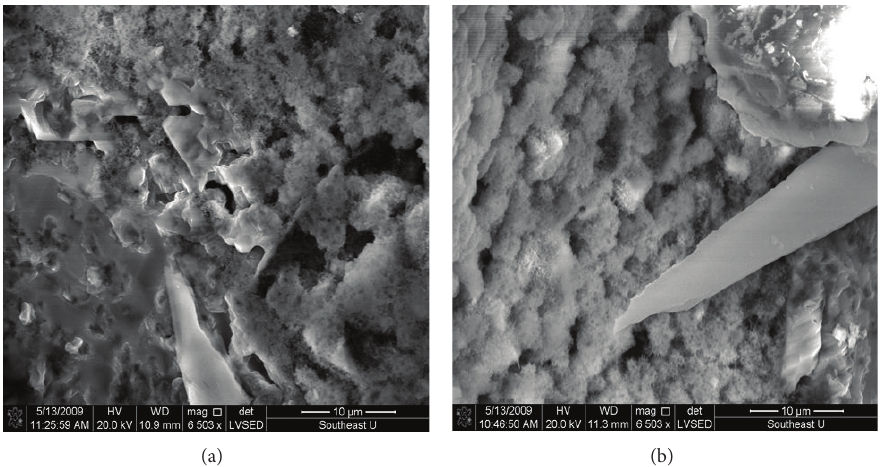
Figure 6: ESEM images of concrete microstructure with LP at different hydration ages: (a) 3 days and (b) 28 days.